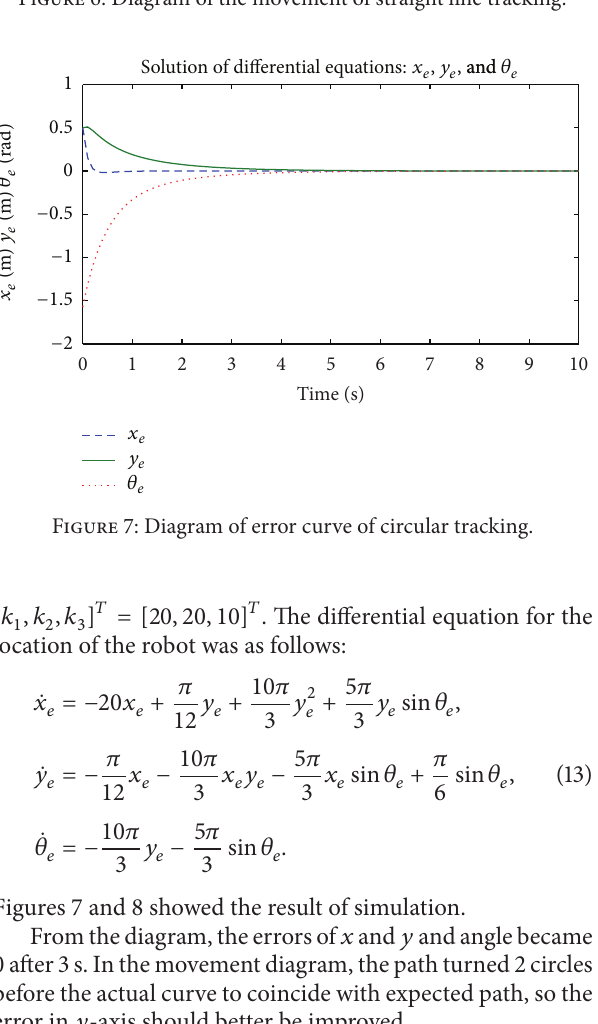
Figure 6: Diagram of the movement of straight line tracking.